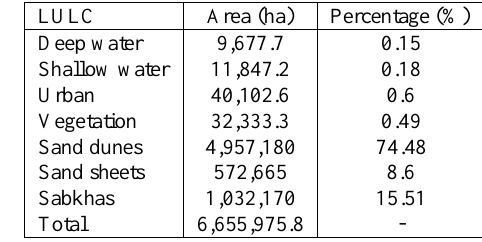
Table 1. Areas and percentages of the study area LULC map classes